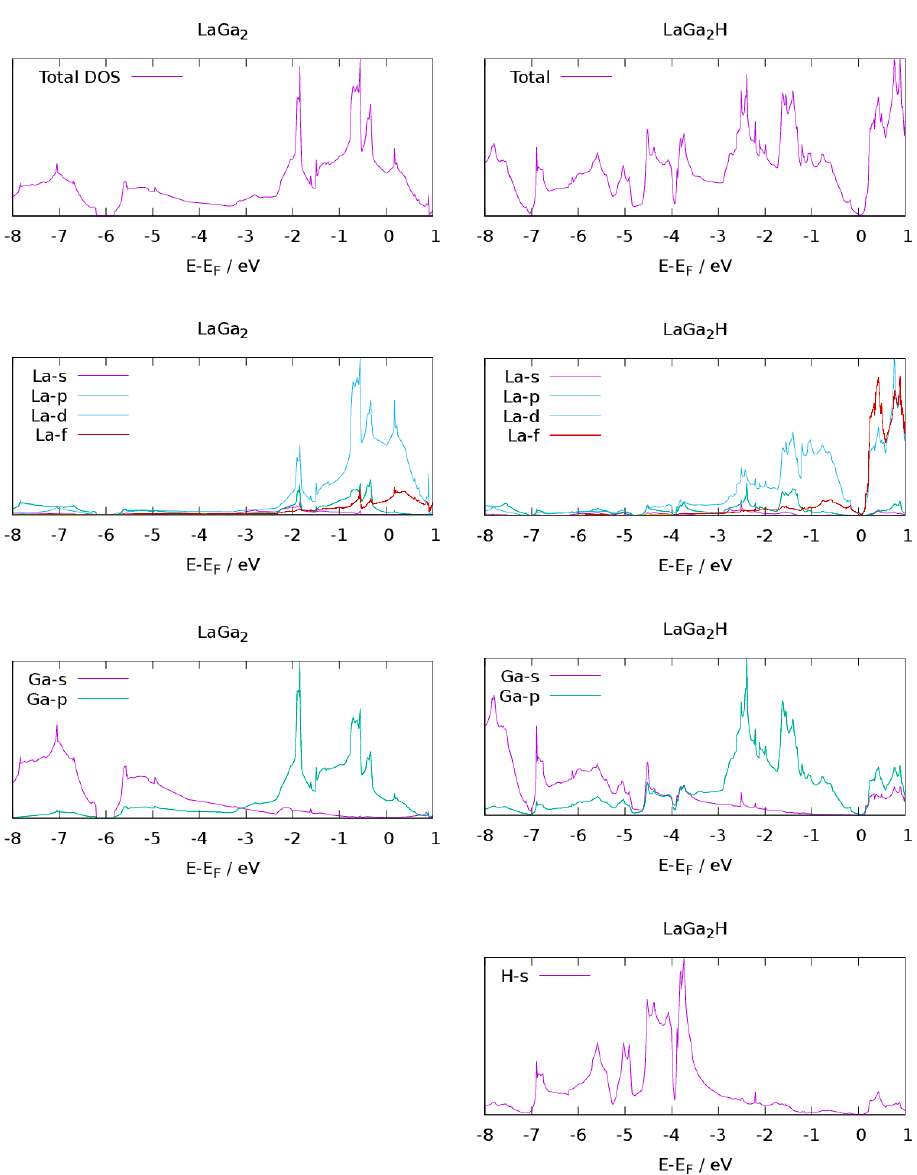
Figure 5. Total (tDOS) and l-resolved partial (pDOS) density of states of LaGa 2 and LaGa 2 H; energies are referenced to the Fermi level.